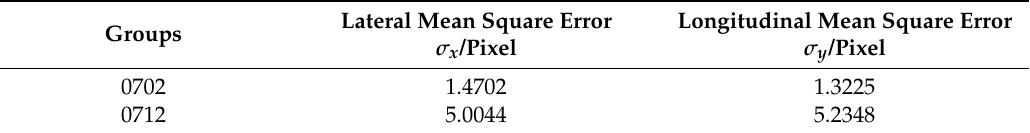
Table 5. The mean square error of the difference between the two groups.